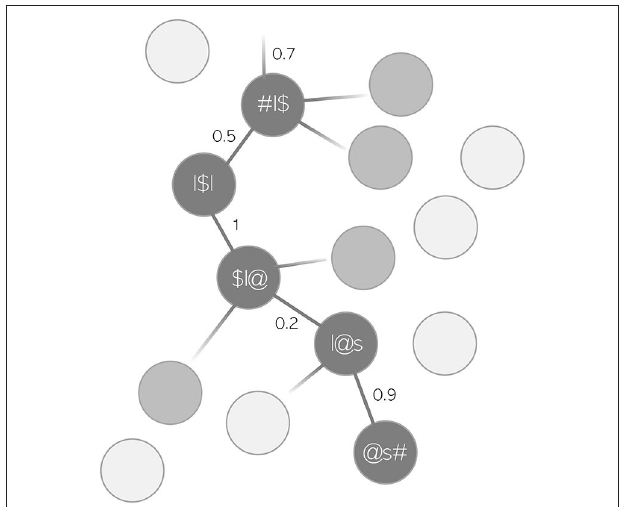
FIGURE 2 | Toy example of an articulatory path for the word lawless . Each connection between a triphone node is assigned a probability of being selected against other